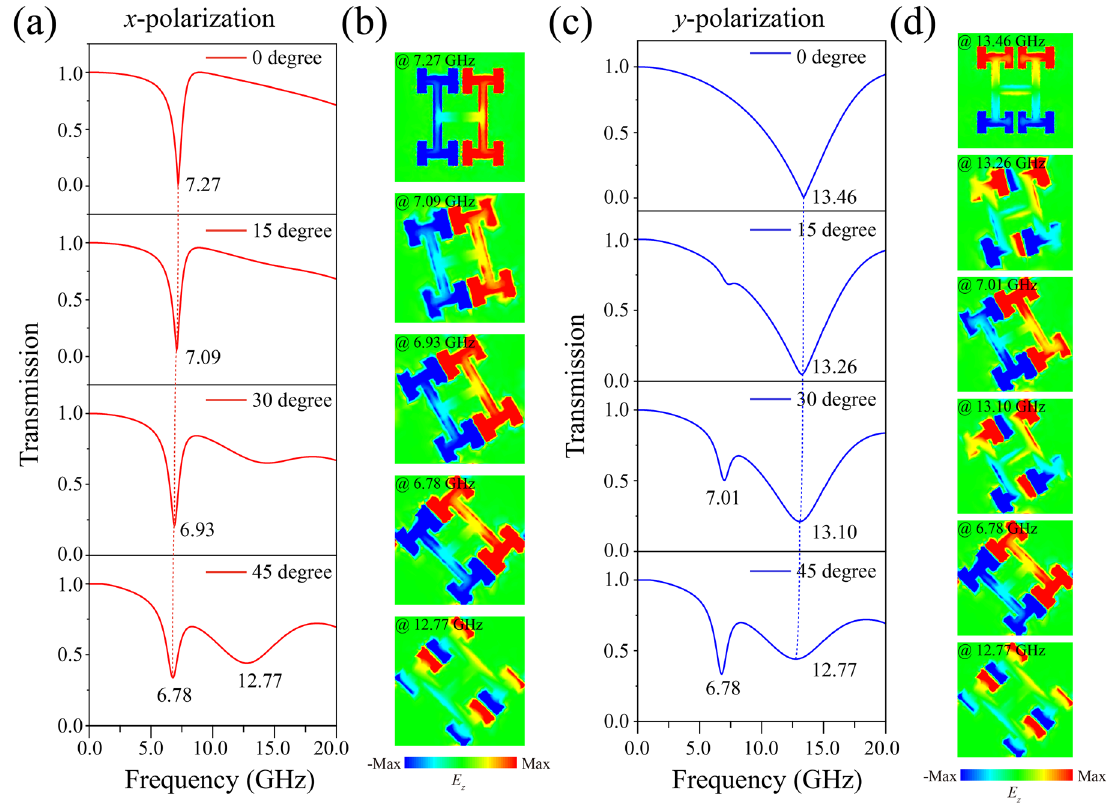
Figure 3: Transmittance spectra and E z fi eld distributions. (a and c) Normalized transmittance spectra when the incident waves are polarized in the x and y directions, respectively. (b and d) E z fi eld distributions on the surface of the unit cells at the resonance valleys corresponding to (a) and